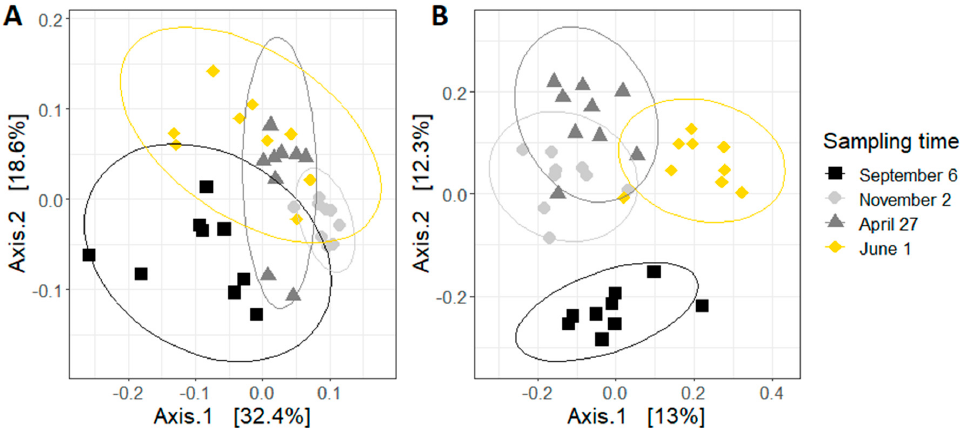
Figure 4. Principal coordinate analysis (PCoA) based on ( A ) unweighted and ( B ) weighted UniFrac distance of samples. Each point represents a colony. Ellipses indicate the 95% confidence intervals.